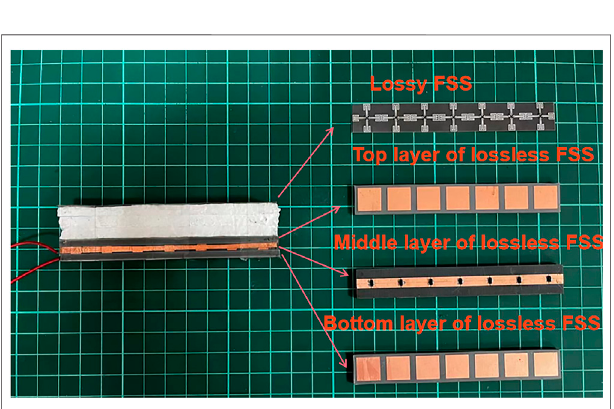
FIGURE10 | Structure of fabricated FSR.